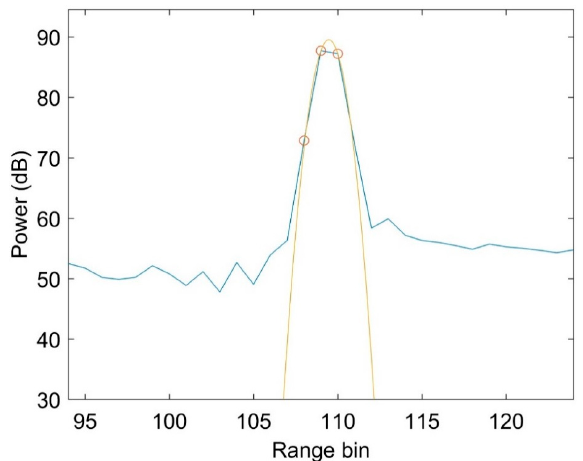
Figure 8. Example of two-bin range solution.